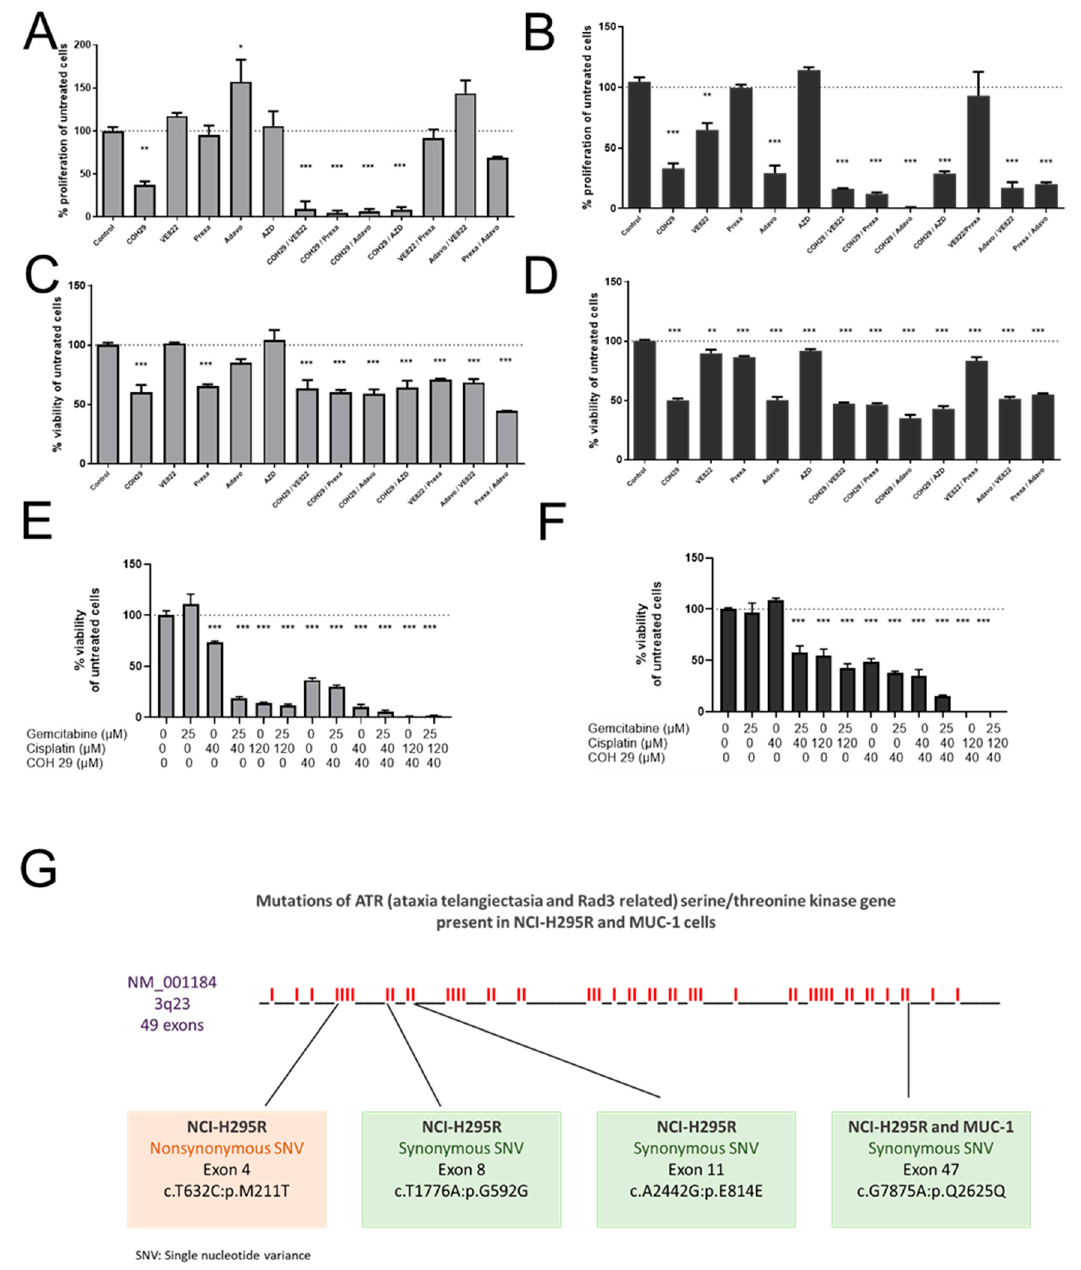
Figure 6. Cell viability and proliferation assays: NCI-H295R ( A , C ) and MUC-1 ( B , D ) cell lines were incubated with different inhibitors of the ATM/ATR signaling pathway. Stars represent significance vs. nontreated (*, p < 0.05; **, p < 0.01; ***, p < 0.001). Cell viability assays of NCI-H295R and MUC-1 cells upon treatment with different dosages of gemcitabine, cisplatin, and COH29 ( E , F ). Stars represent significance vs. nontreated (*, p < 0.05; **, p < 0.01; ***, p < 0.001). Mutations of the ATR gene detected in the NCI-H295R and MUC-1 cell lines ( G